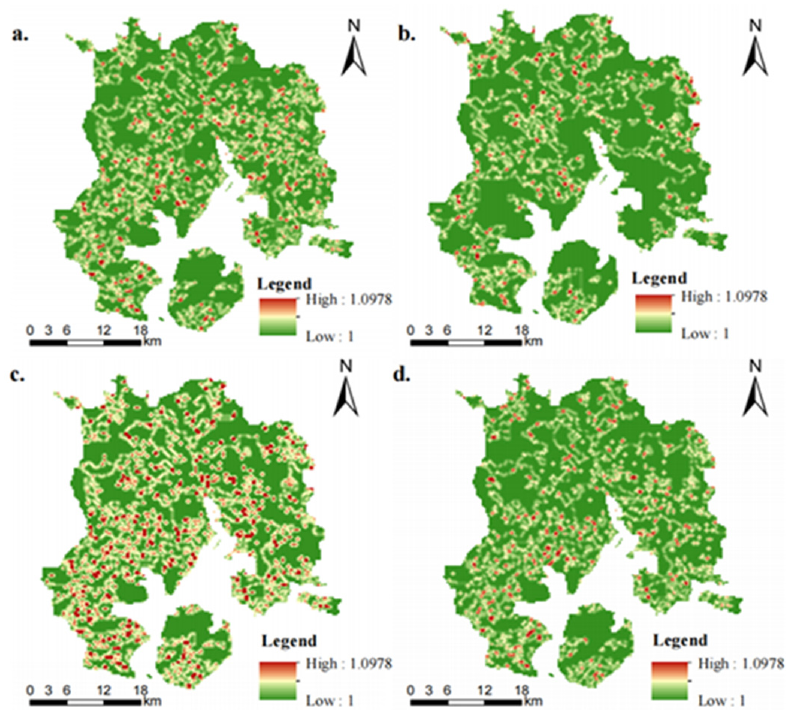
Figure 5. Land use disturbance index distribution in 2020 and 2030: ( a ) 2020; ( b ) NDS; ( c ) PIS; and ( d ) SDS.